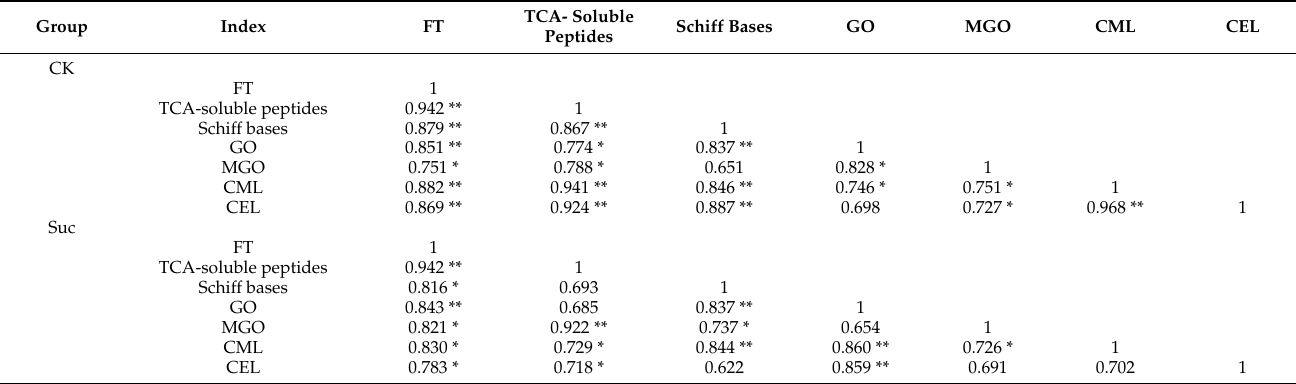
Table 4. Correlation analysis between freeze–thaws (FT), TCA-soluble peptides, Schiff bases, GO, MGO, CML and CEL indicators in cooked